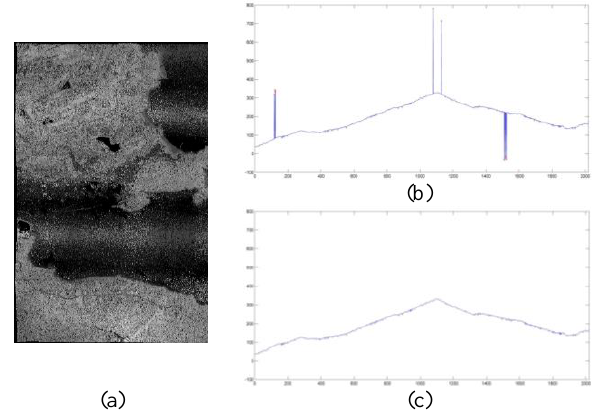
Figure 5. Denoising and result of the first dataset: (a) Gray-scale image rendered using intensity values; (b) A horizontal profile of the DSM (red crossed symbols indicate outliers); and (c) The corresponding result after